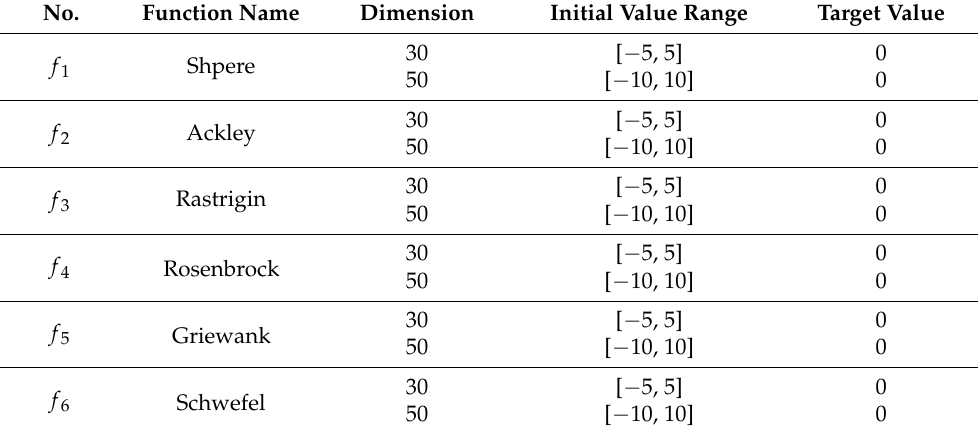
Table 1. The dimensionality, initial value range and target value of the benchmark